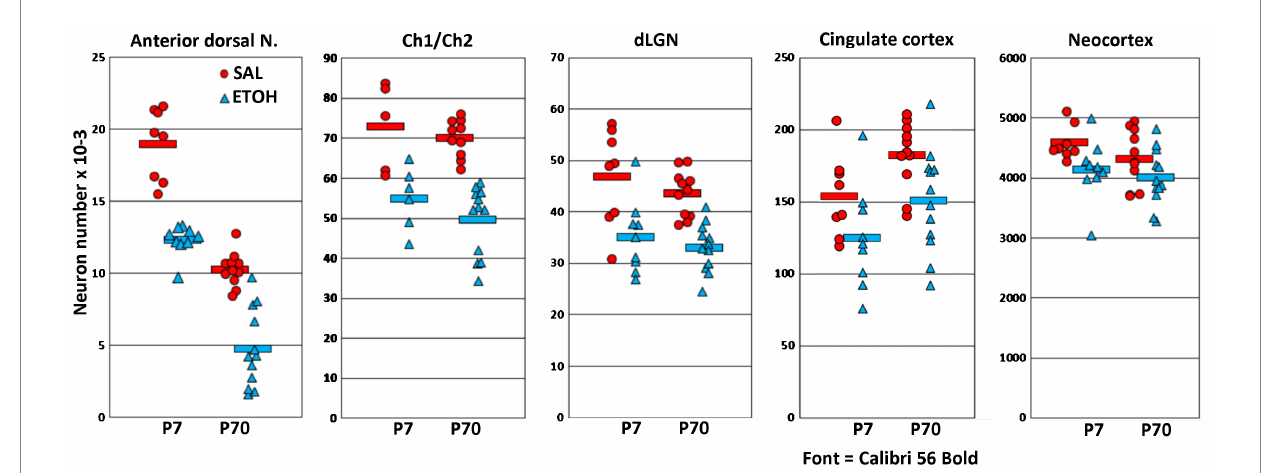
FIGURE 2 Graphs compare estimates of neuron number at P7 and P70 in 5 different areas, in saline (SAL) and ethanol (ETOH) treated mice. The graphs are ordered from left to right by severity of the ethanol effect. In all regions, the reduction of neuron number was not significantly different at P7 compared to P70. Ethanol caused the largest reduction in the anterior dorsal nucleus, and this nucleus also had a striking age effect, such that neuron number was higher at P7 than P70 in both the saline and ethanol treatment